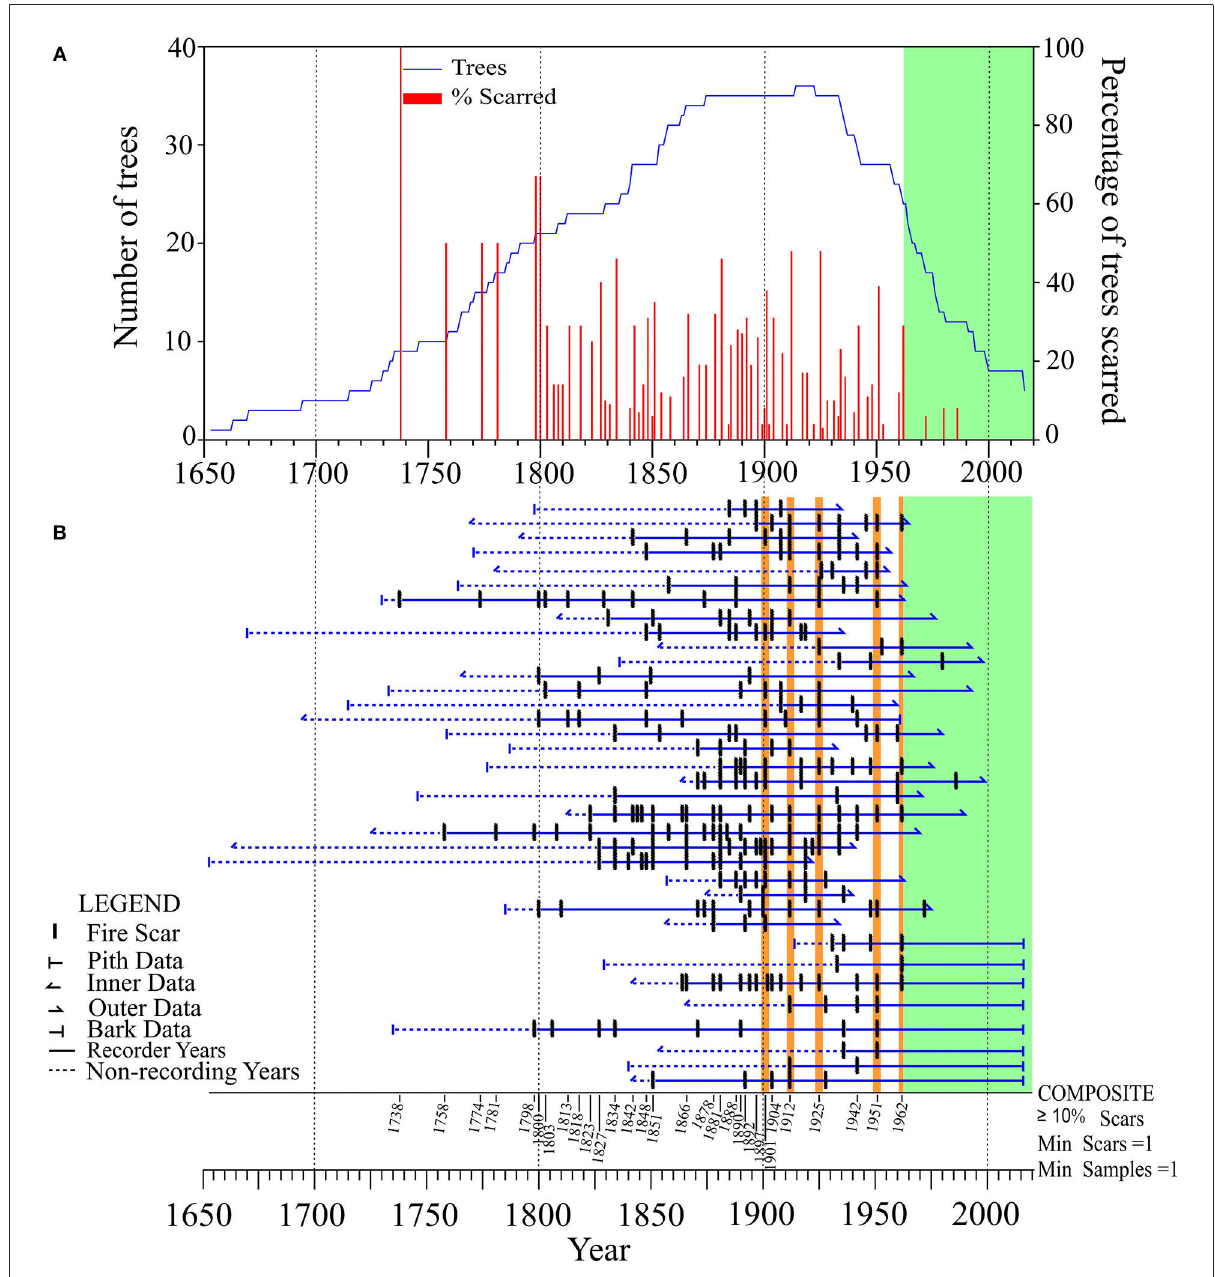
FIGURE3 Fire history timeline in a Pinus lumholtzii forest site in Rio Miravalles, San Dimas, Durango. (A) Percentage of recording fire scarred trees (blue line) and percent of trees that recorded a fire by year. (B) Individual fire-scarred tree timeline represented by horizontal lines in blue and vertical black dashes representing fire-scars recorded by that tree. Year when 10% or more trees recorded a fire are displayed along the bottom of the graph. The orange highlighted area indicates more extensive fire years. The green-highlighted area shows a period without extensive fires and a change in fire frequency after